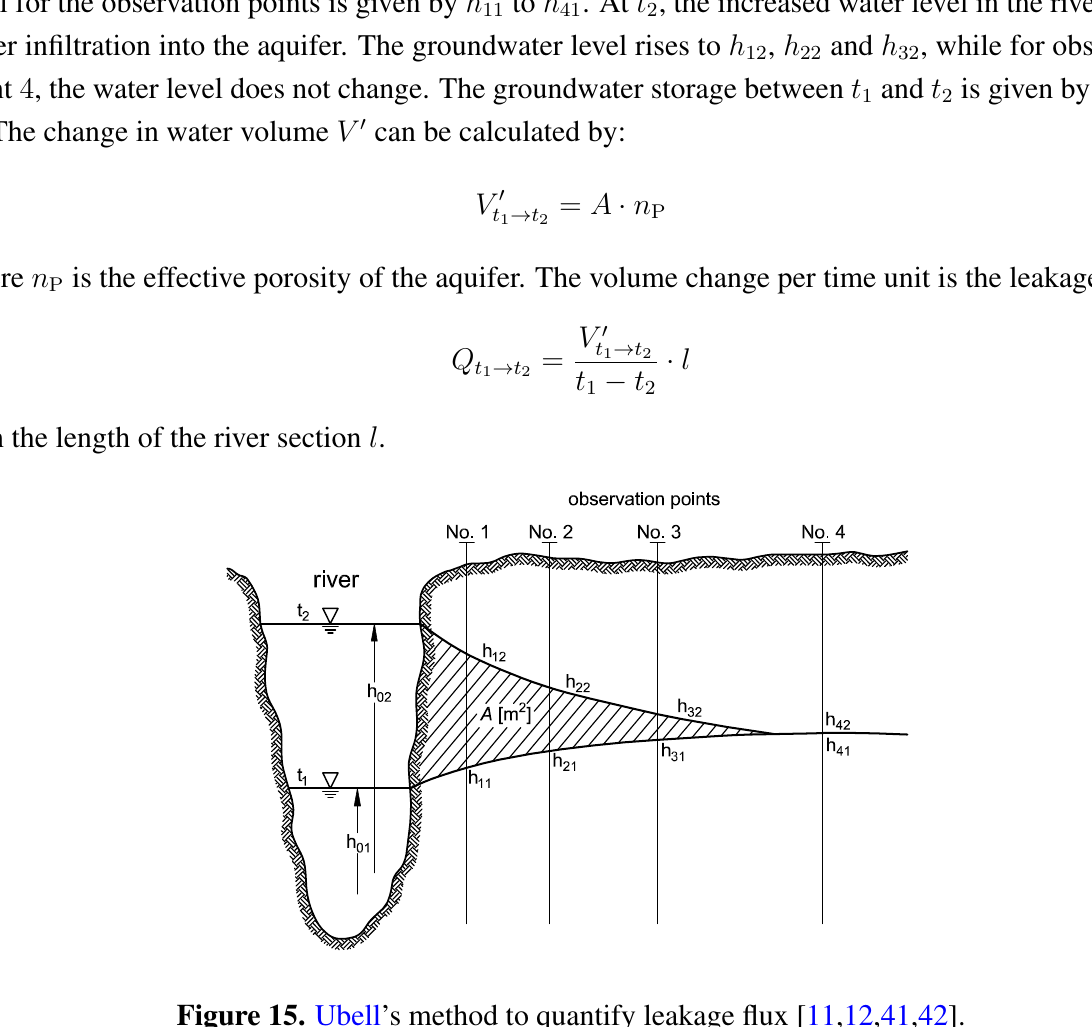
Figure 15. Ubell’s method to quantify leakage flux